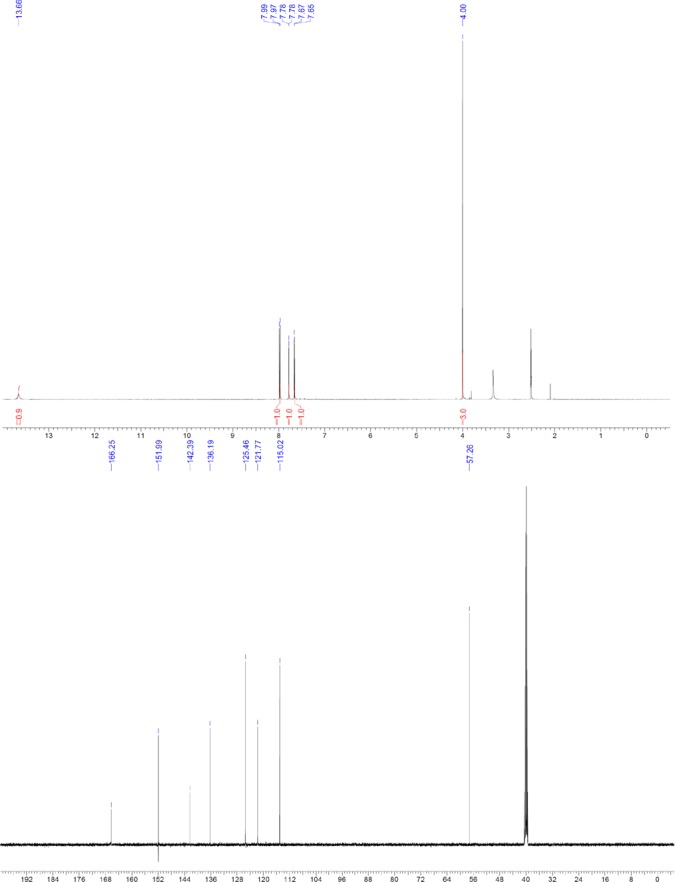
1H and 13C NMR of compound 3a.